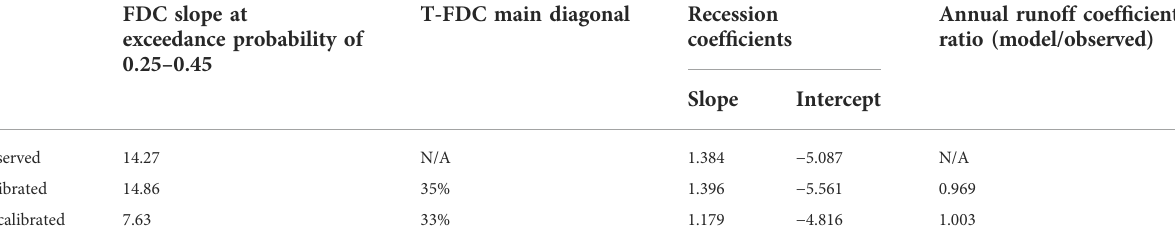
TABLE 5 Numerical scores of hydrological signature metrics. For this test case, we chose the mid slope of the FDC (25 – 45% exceedance probability). Similarly, we chosethe main diagonal in T-FDC as a strict measure and ‘ Dry ’ months (April — September) for recession score as a representativeof subsurface fl ow dominant season. HydroBench allows users to choose the exceedance probabilities, the number of diagonals in T-FDC and seasons for recession curve